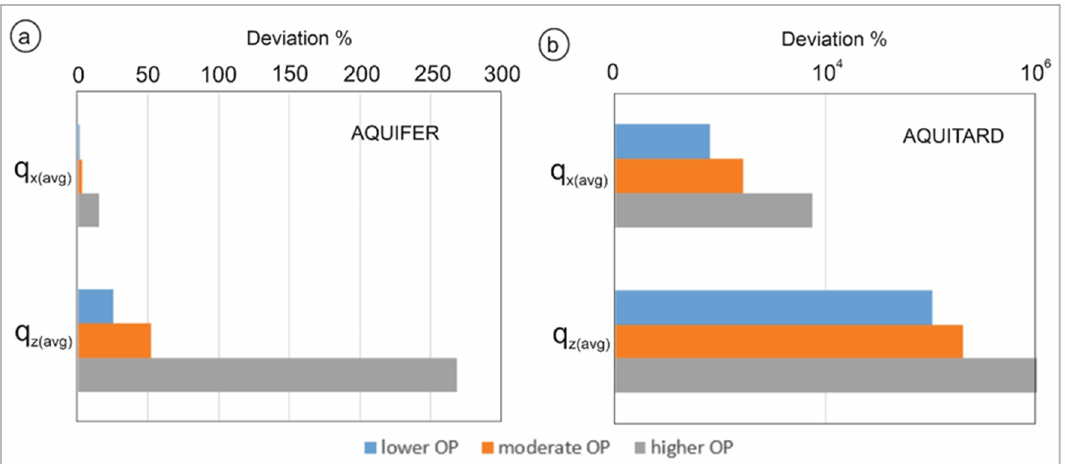
Figure 6. Deviation of flow dynamics ( a ) within the aquifer and ( b ) within the aquitard induced by recharge reduction after 80 yr in case of the different scenarios (lower, moderate and high overpressure at the bottom of the system). “ q x(avg) ” and “ q z(avg) ” represents average Darcy fluxes in the horizontal and vertical directions, respectively. Reference (0%) is the corresponding flux of the initial case without overpressure after 80 yr.